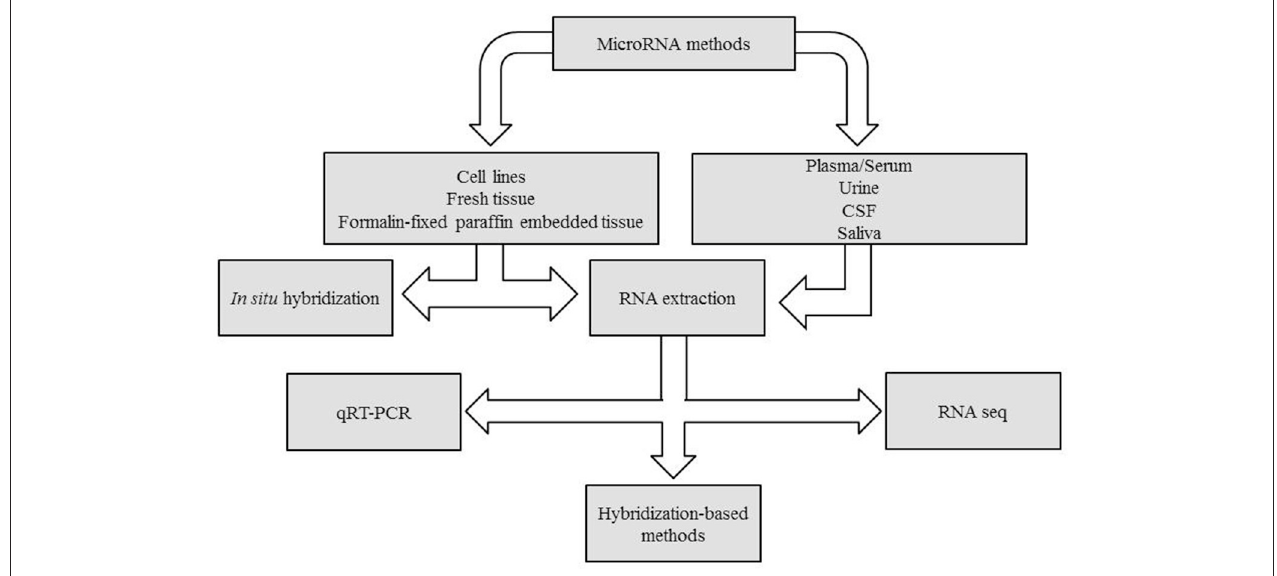
FIGURE 1 | Decision making chart. MiRNAs can be extracted from different sample types, such as tissues and body fluids. The experimental design determines the methodology chosen for miRNA